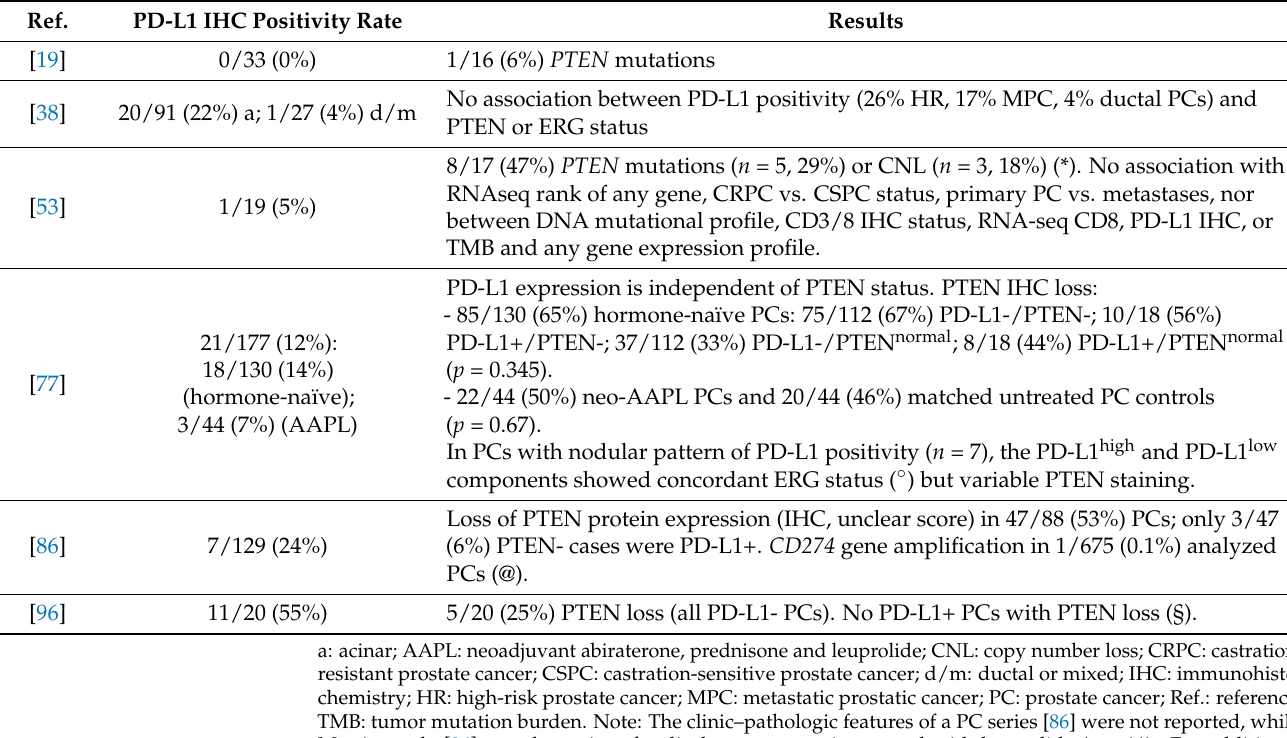
Table 3. PD-L1 expression and PTEN status in patients with prostatic